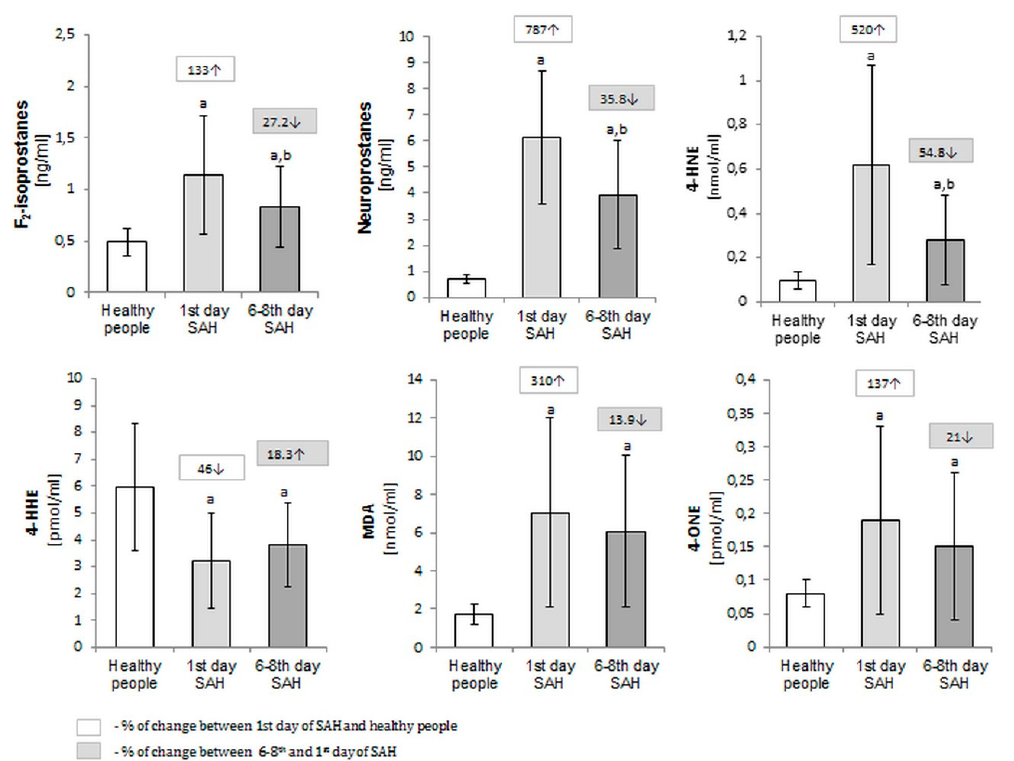
Figure 2. The lipid peroxidation products (F 2 -isoprostanes, neuroprostanes, 4-HNE, 4-HHE, MDA and 4-ONE) level in plasma of healthy people ( n = 30) and SAH- patients ( n = 30) at the 1st and 6–8th day after SAH.; a p < 0.05 in comparison with healthy people. b p < 0.05 in comparison with patients on the 1st day after SAH.